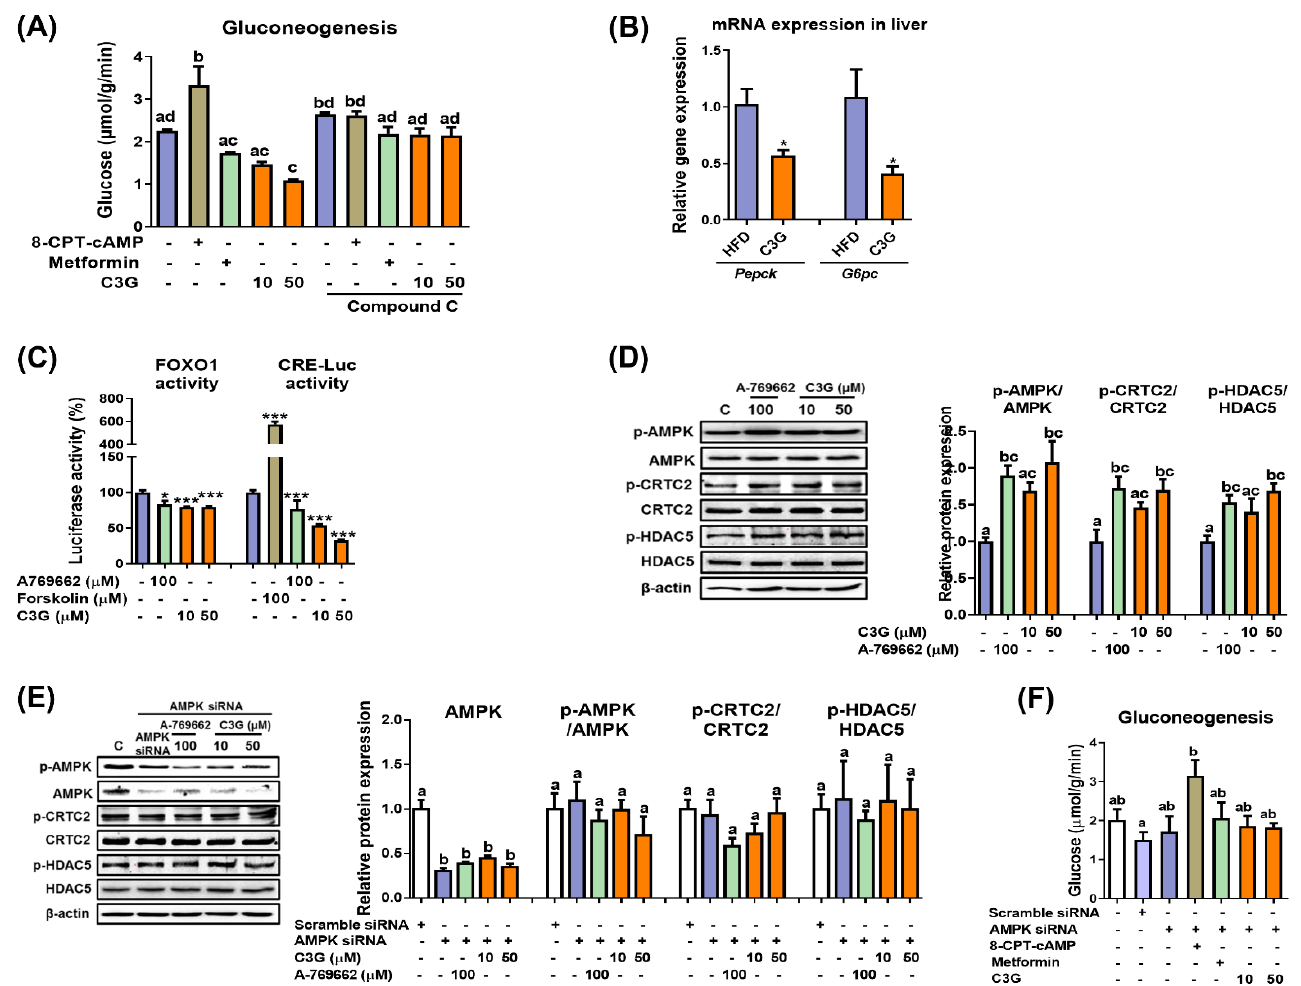
Figure 1. C3G activates AMPK and reduces gluconeogenesis through suppression of gluconeogenic gene expression. ( A ) Rate of gluconeogenesis in HepG2 cells incubated with C3G. 8-CPT-cAMP is a cAMP analogue. Metformin is an AMPK activator, while compound C is an AMPK inhibitor. ( B ) mRNA expression of gluconeogenic genes measured through qPCR. Transcription factor activity assay. ( C ) The activities of FoxO1 and CRE were measured using a luciferase assay. A769662 is an AMPK activator, and forskolin is an adenylate cyclase activator. ( D ) C3G stimulates AMPK, CRTC2 and HDAC phosphorylation in HepG2 cells. ( E ) AMPK, CRTC2 and HDAC5 phosphorylation in HepG2 cells with AMPKα1 gene knockdown. ( F ) Rate of gluconeogenesis in HepG2 cells following AMPKα1/α2 gene knockdown. For comparisons between two groups, Student’s t -test was performed. *, p < 0.05; ***, p < 0.005 compared with controls. For multiple-group comparisons, one-way ANOVA was performed. Different letters indicate statistically significant differences at p < 0.05.